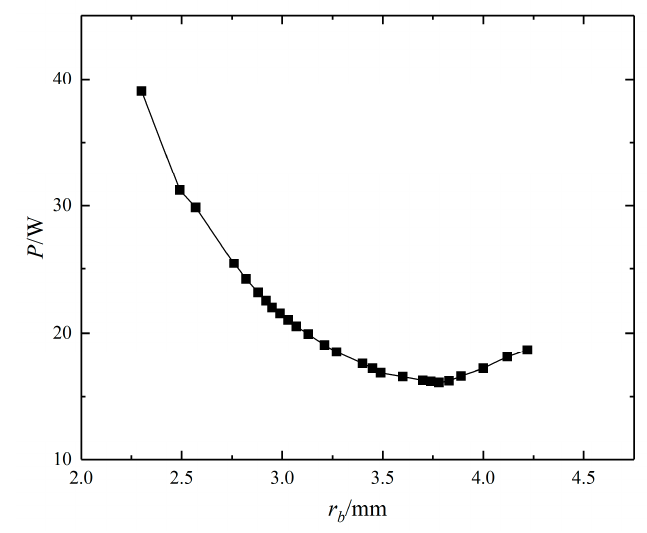
Figure 9. Optimal total pumping power consumption under different r b .